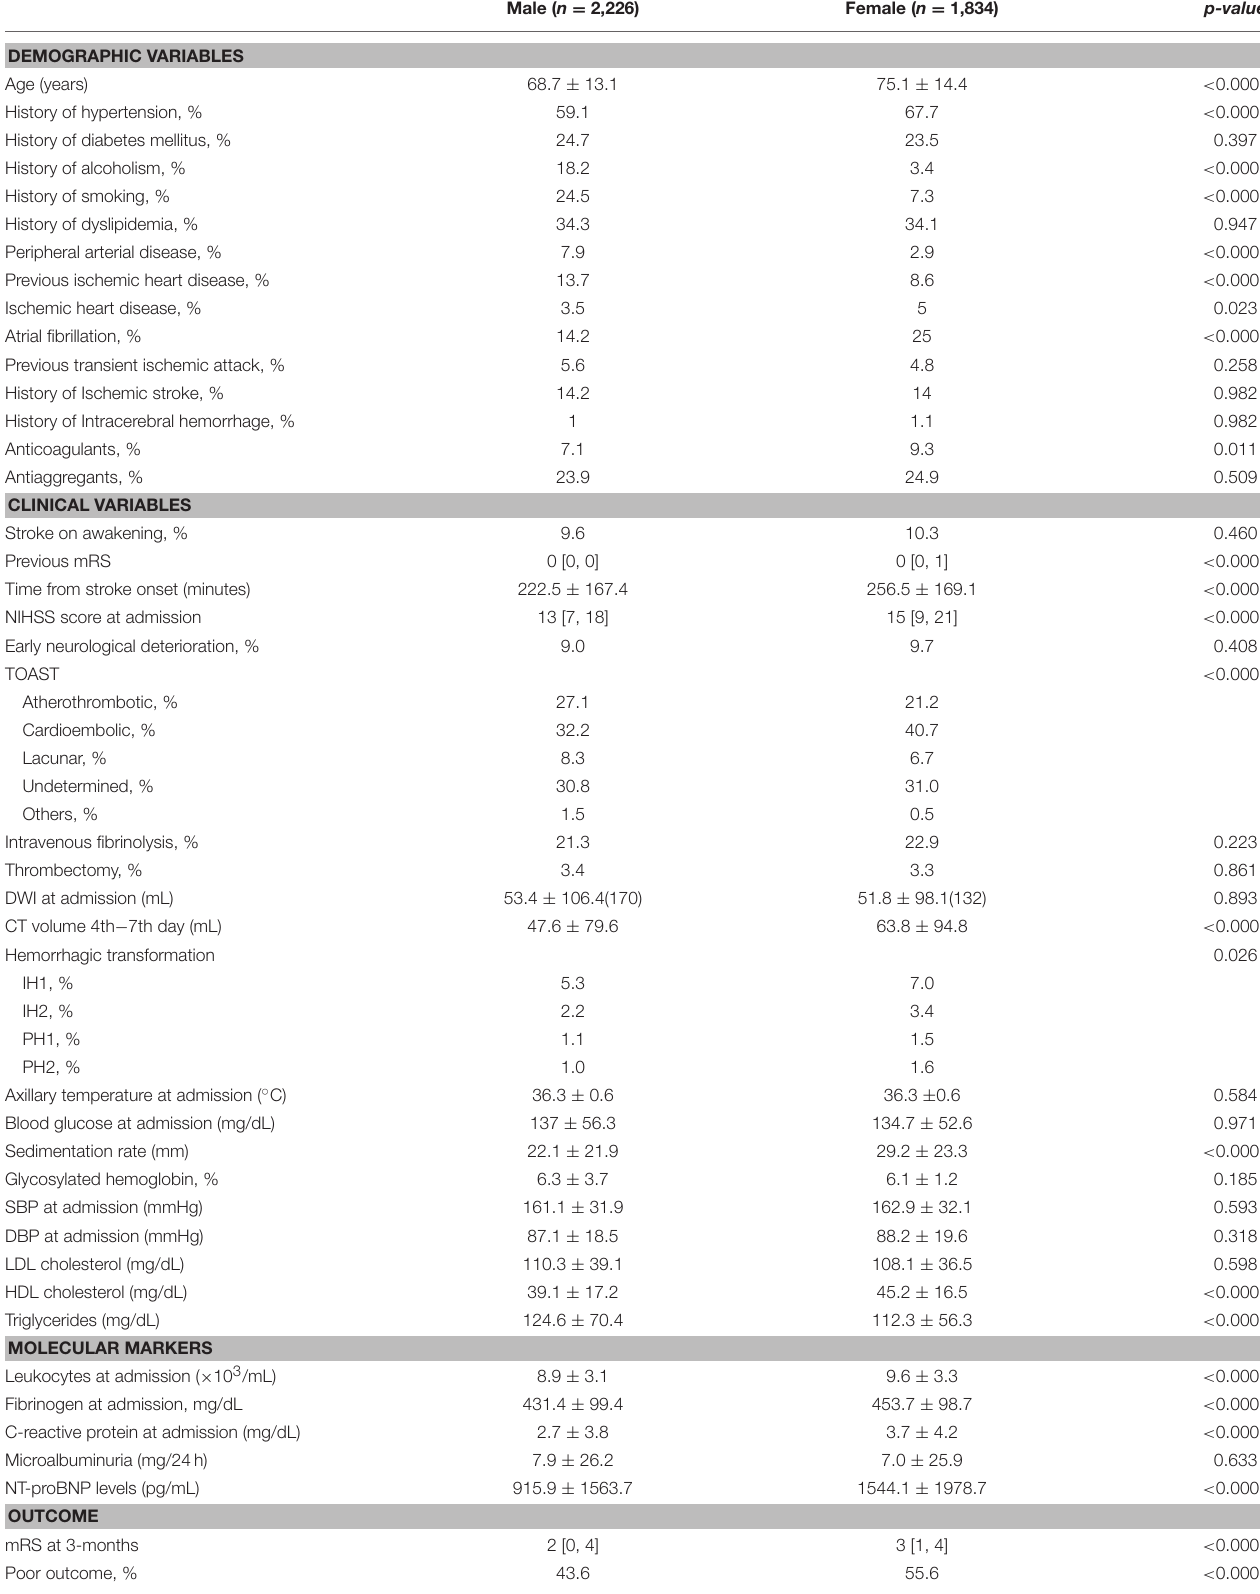
TABLE 1 | Univariate analysis according to sex in ischemic stroke patients ( n = 4,060). Male ( n = 2,226) Female ( n = 1,834)